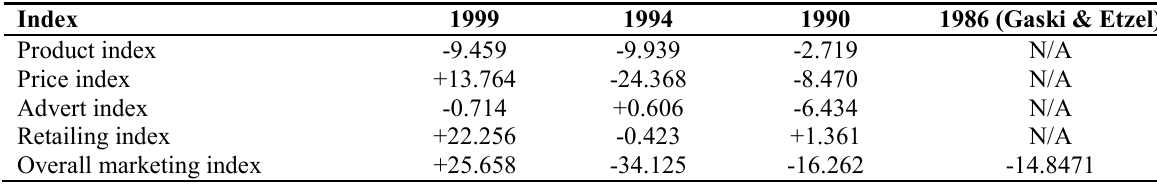
Table 5: The South African marketing index - 1999